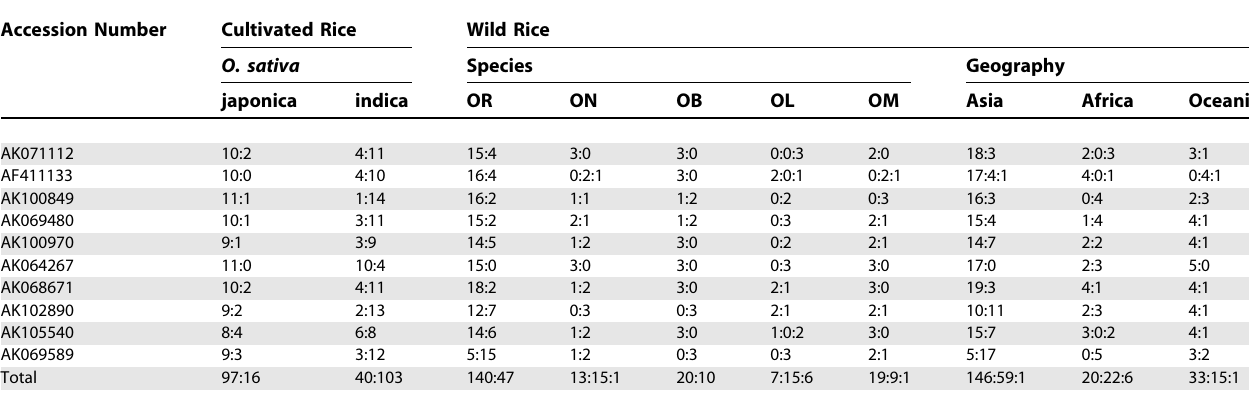
Table 2. The Distribution of Haplotypes for High Polymorphism Genes by Species or Geography